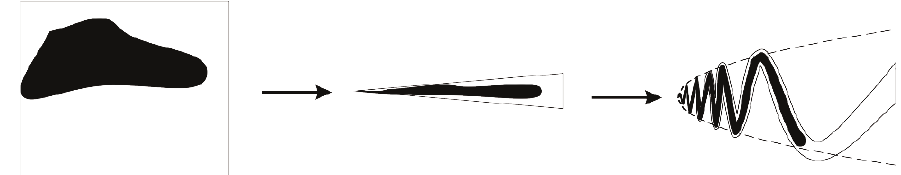
Figure 1. The map h for n